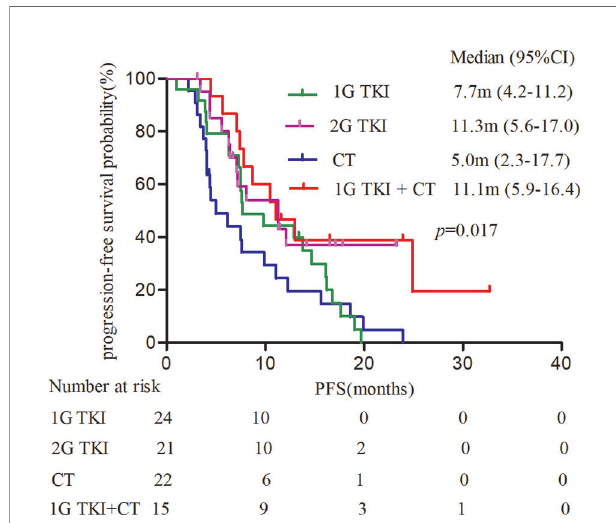
FIGURE 2 | Kaplan-Meier curves of PFS in patients harboring EGFR exon 18 mutations treated with different treatment modalities. (PFS, progression- free